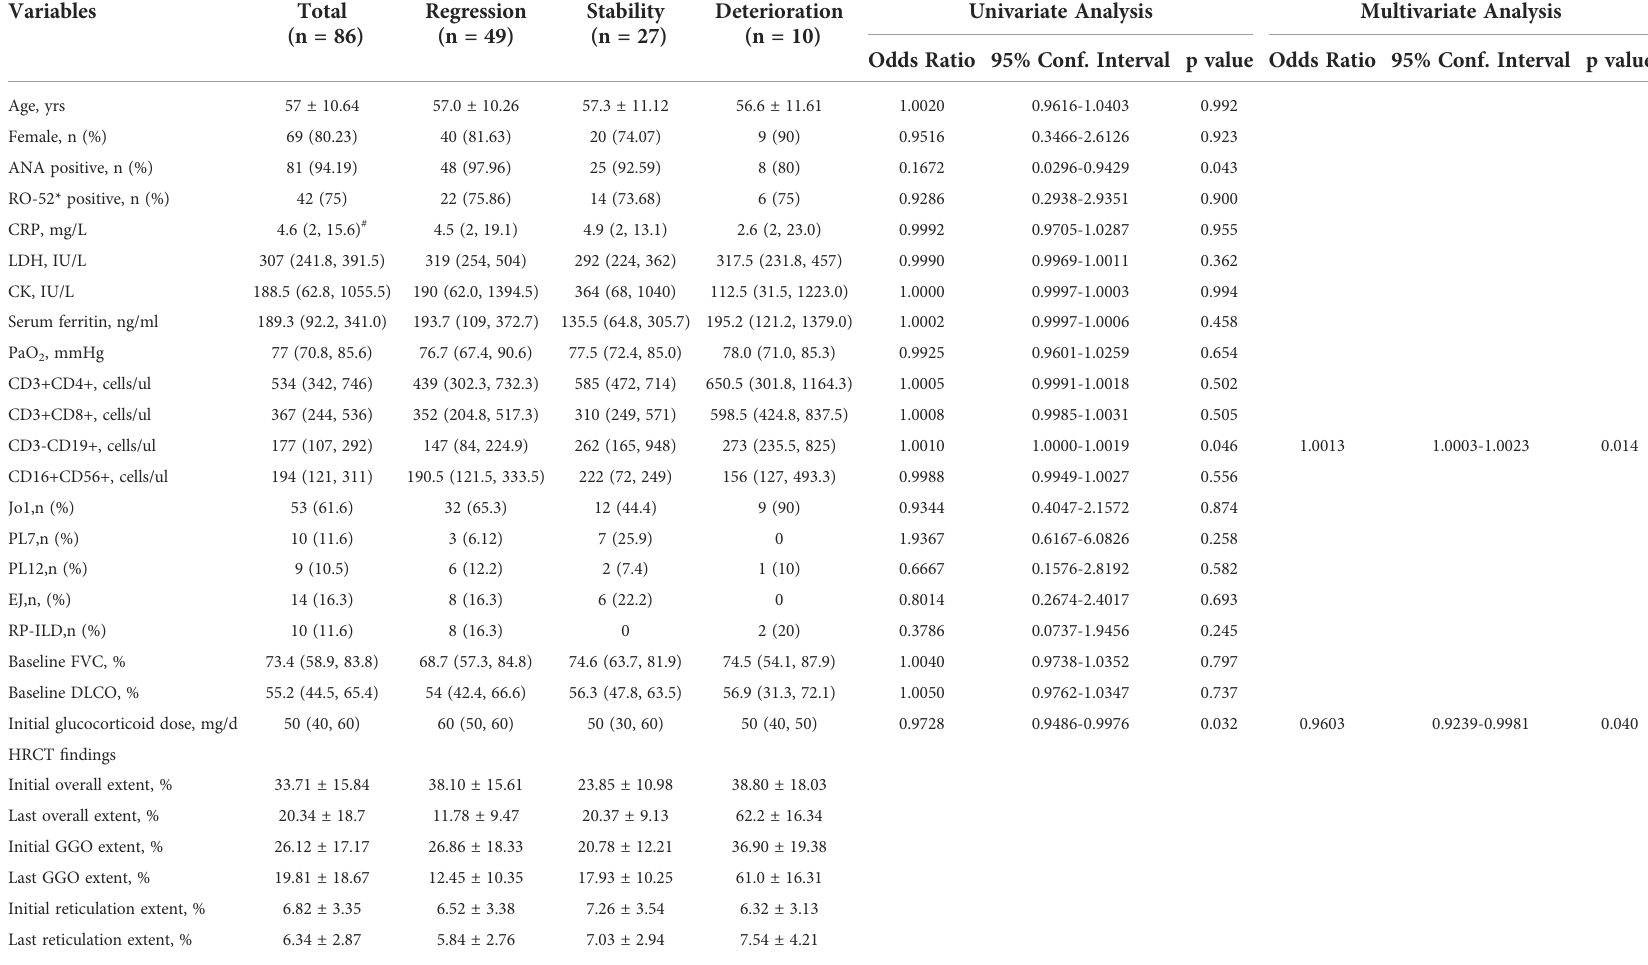
TABLE 4 Analysis on the prognostic factors of imaging progress in patients with